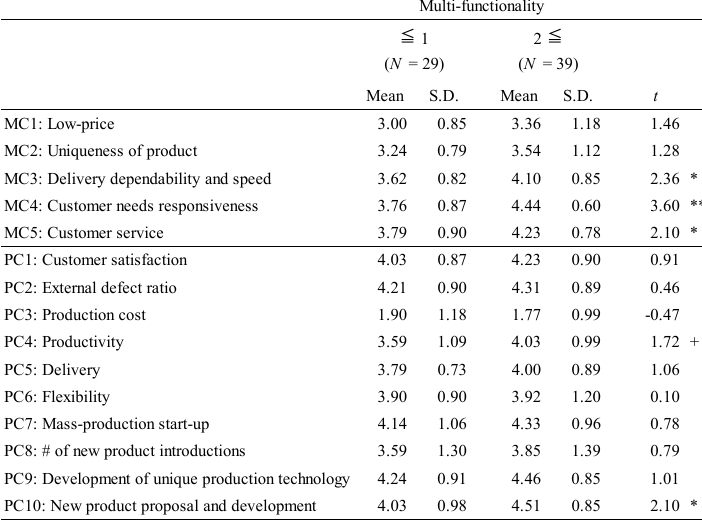
Table 1. Differences in means of